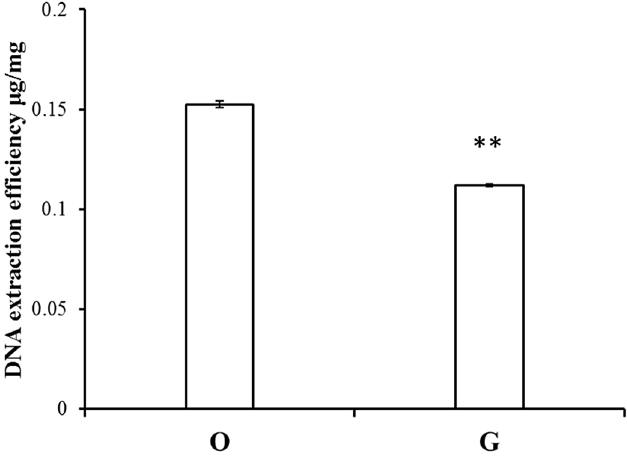
Fig. 2. The productivity of shell DNA extraction with the improved organic solvent extraction (O) versus guanidine lysis buffer (G) methods. Each bar represents the mean ±SD ( n =6). **( P <